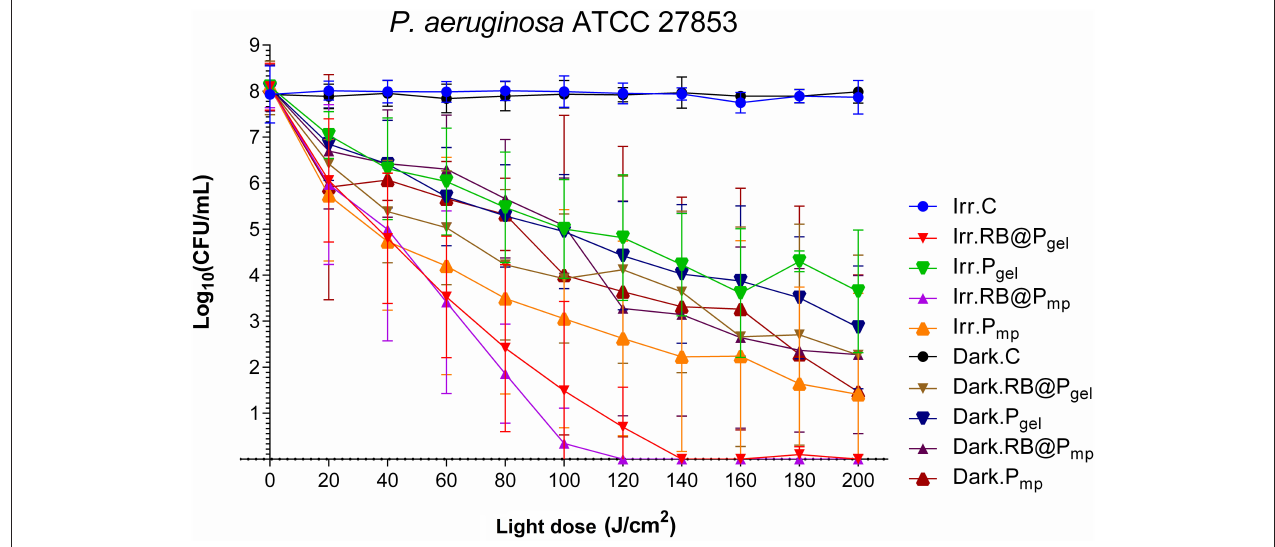
FIGURE 4 | Survival curves corresponding to the photodynamic inactivation of Pseudomonas aeruginosa . Every point is the average of three independent experiments. Error bars correspond to the standard deviations. Legend titles: Irr , irradiated samples; Dark , controls in the darkness; C , control, only microbial suspension; RB@P gel , Amberlite ® IRA-400 (P gel ) loaded with Rose Bengal (RB); P gel , P gel resin without RB; RB@P mp , Amberlite ® IRA-900 (P mp ) loaded with RB; P mp , P mp resin without RB. Adapted from (34). Copyright 2020 with permission from Elsevier.